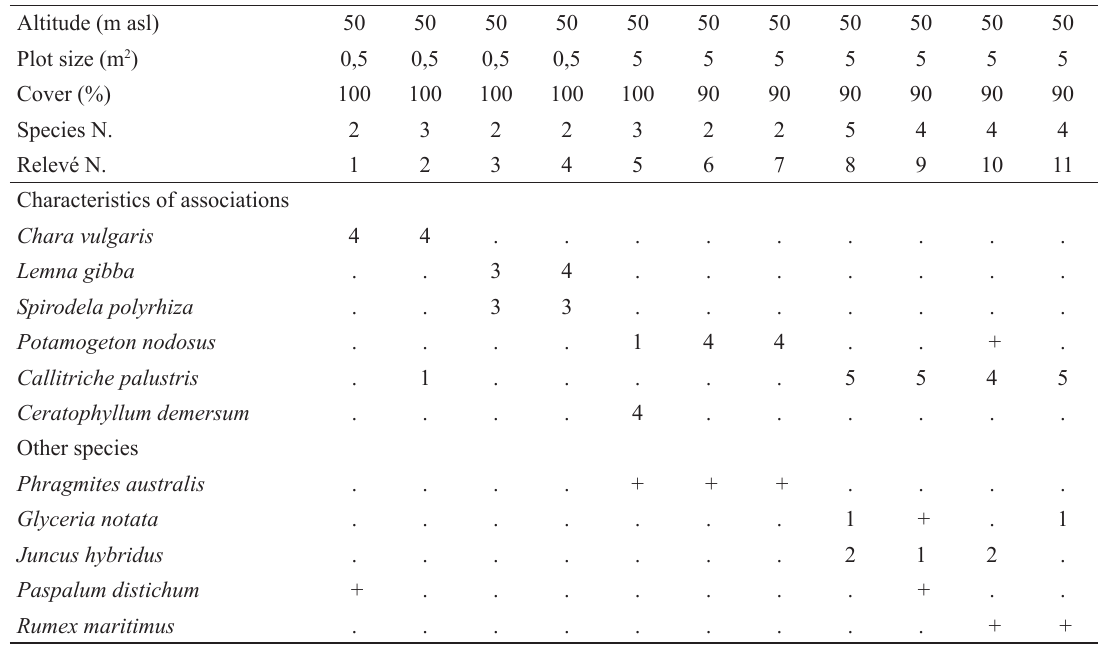
Juncus hybridus Rumex